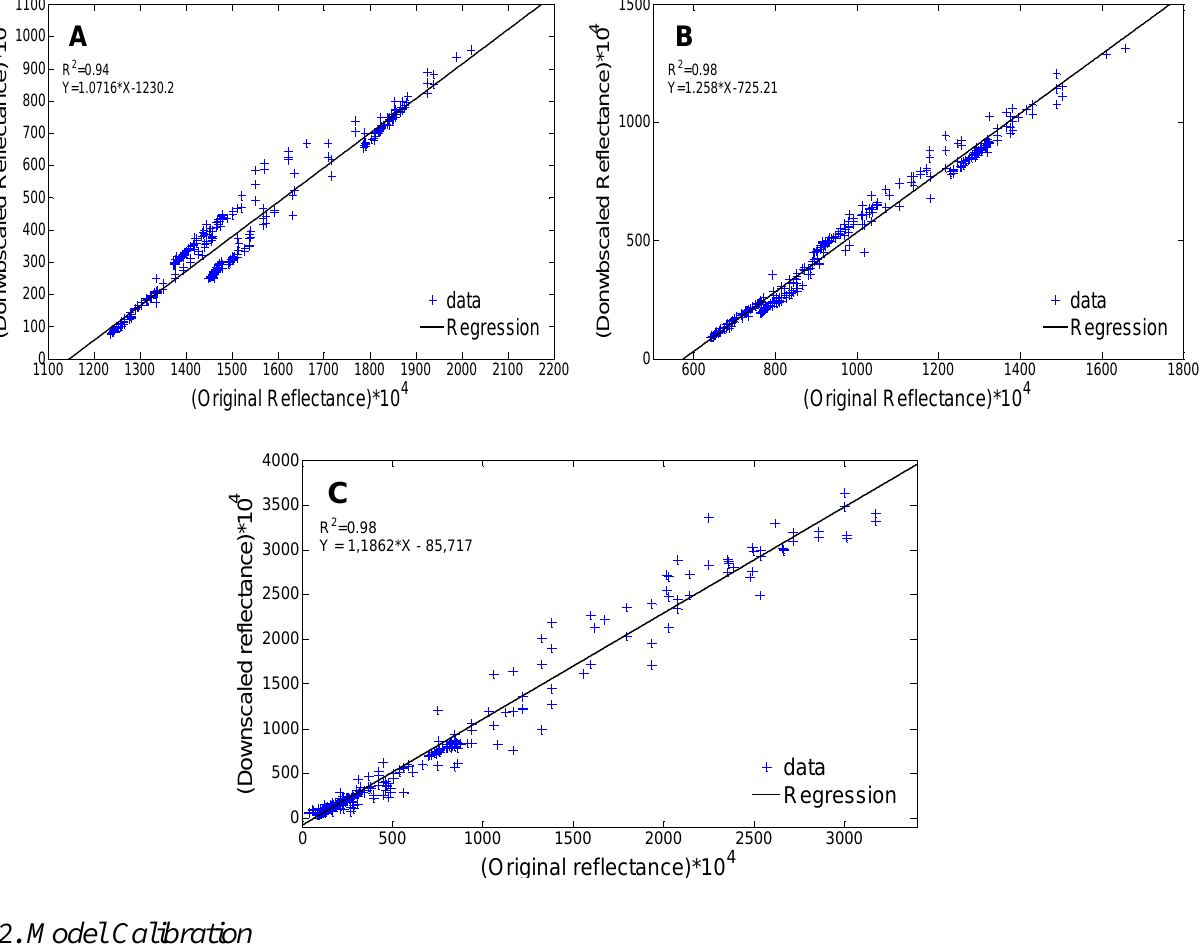
Figure 4. Correlation between the original and the downscaled reflectance used in the estimation models of chlorophyll-a concentration. ( A ) Band 3, ( B ) Band 4, and ( C ) Band